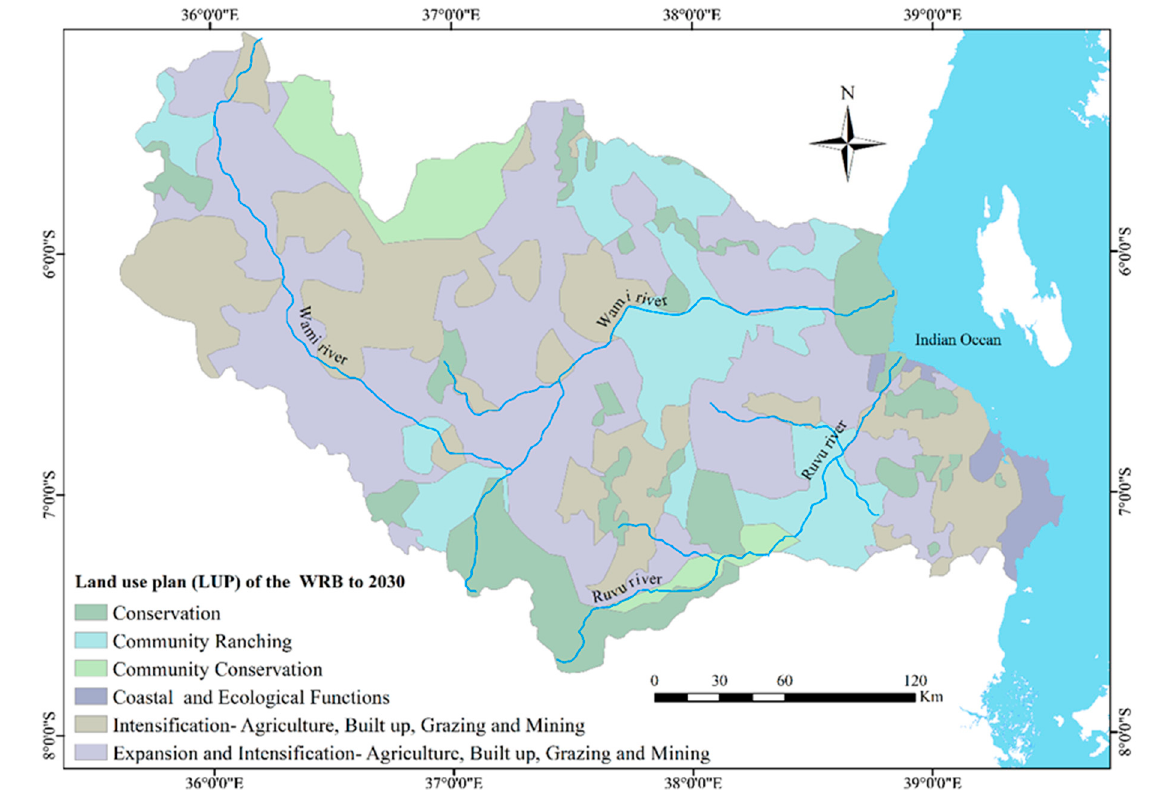
Figure A4. The land-use plan of the Wami–Ruvu Basin modified from [49].